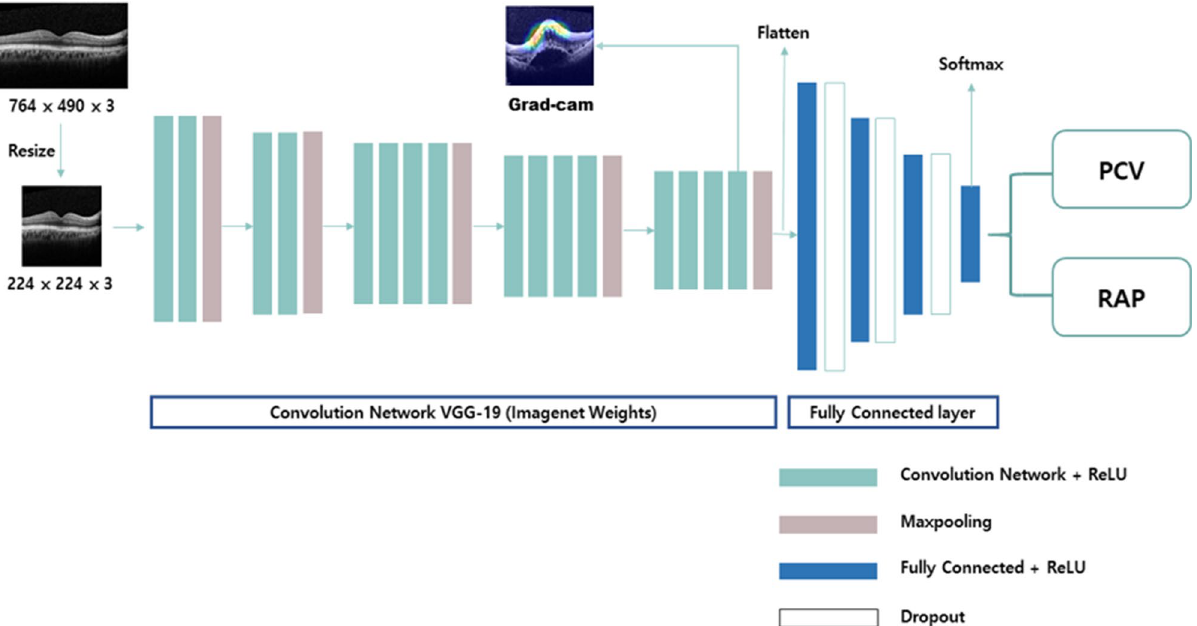
Figure 5. Network architecture of the modified VGG-19 used for classifying PCV and RAP. Our model consisted of an input layer, 16 CNN layers with ReLU activation functions, 5 max-pooling layers, 3 dropout layers, and 4 fully connected layers with ReLU activation functions. The last fully connected layer was used for binary classification. The heat map was generated from the final CNN layer. CNN, convolutional neural network; Grad-CAM, gradient-weighted class activation mapping; PCV, polypoidal choroidal vasculopathy; RAP, retinal angiomatous proliferation; ReLU, rectified linear